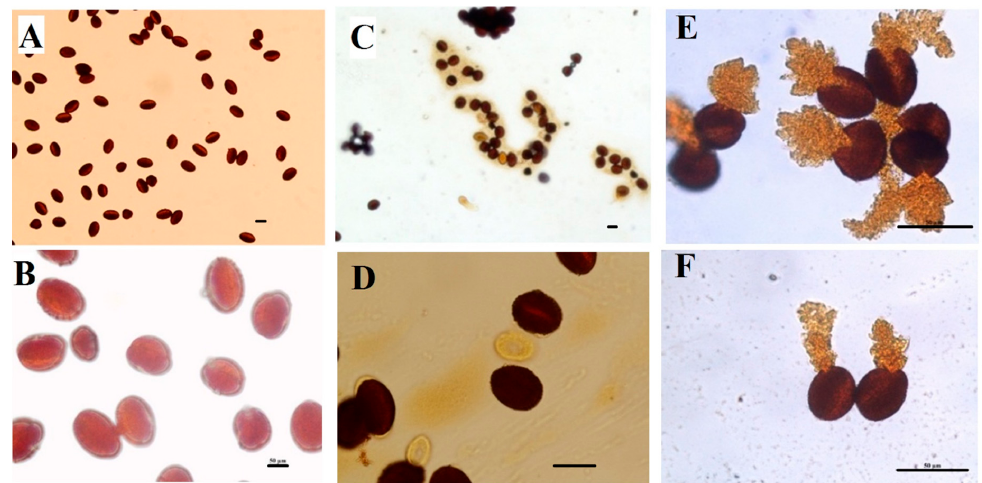
Figure 7. Pollen fertility of B. napus ’ pollen grains. I 2 /KI staining for starch, normal mature pollen grains containing starch granules stain black or dark brown; however, the immature pollen grains appear orange to red; CK ( A , B ) and Cd-treated plants ( C – F ). Pollen from control have uniform shape, but Cd treated plants sometimes have burst pollen. Pollens were collected from plants treated with foliar spray of Se (1 mg/L) and/or Mo (0.3 mg/L) in the absence or presence of Cd stress (5 mg/kg). Scale bar: 50 µ m.